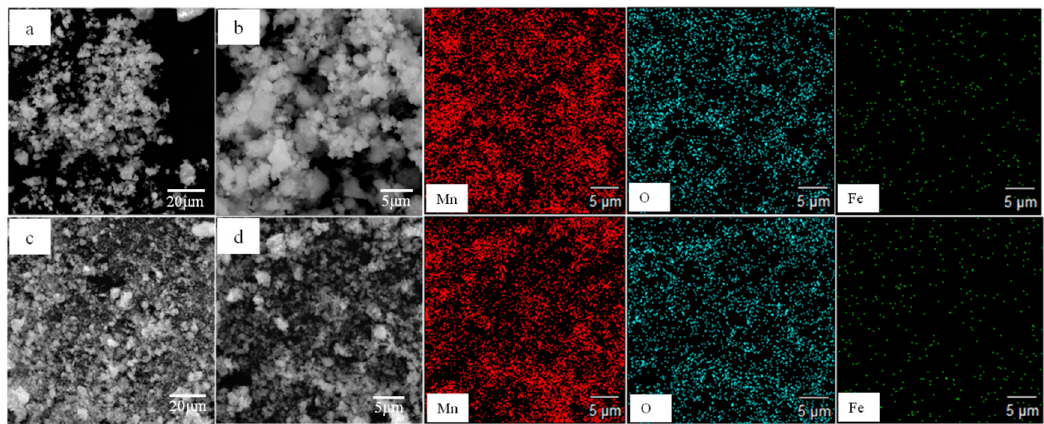
Figure 15. SEM and element distribution map of leaching residues under conventional and ultrasonic conditions. ( a ): SEM at low magnification under conventional conditions; ( b ): a partial enlarged view of ( a ); ( c ): SEM at low magnification under ultrasonic conditions; ( d ): a partial enlarged view of ( c ).